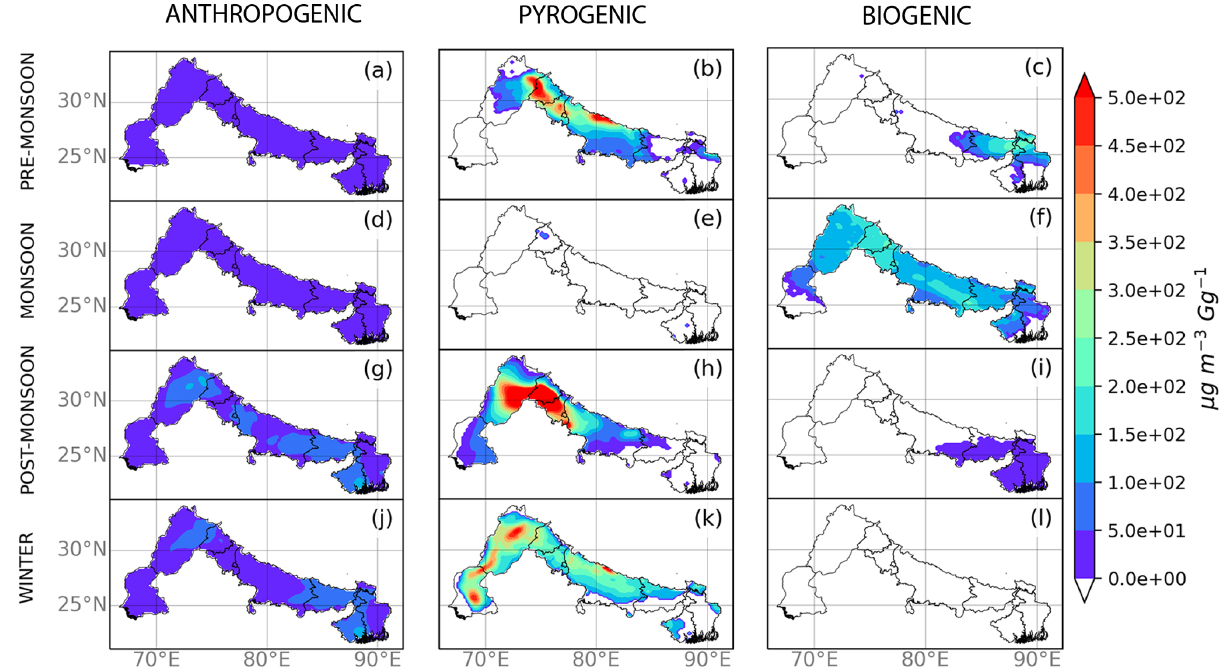
Figure 7. Seasonal sensitivity of total OA to changes in (a, d, g, j) anthropogenic, (b, e, h, k) pyrogenic, and (c, f, i, l) biogenic emissions (µgm − 3 Gg − 1 ). The sensitivity calculation is described in the main text. Regions marked in white show where sensitivity corresponds to OA concentrations below the set threshold of 1µgm − 3